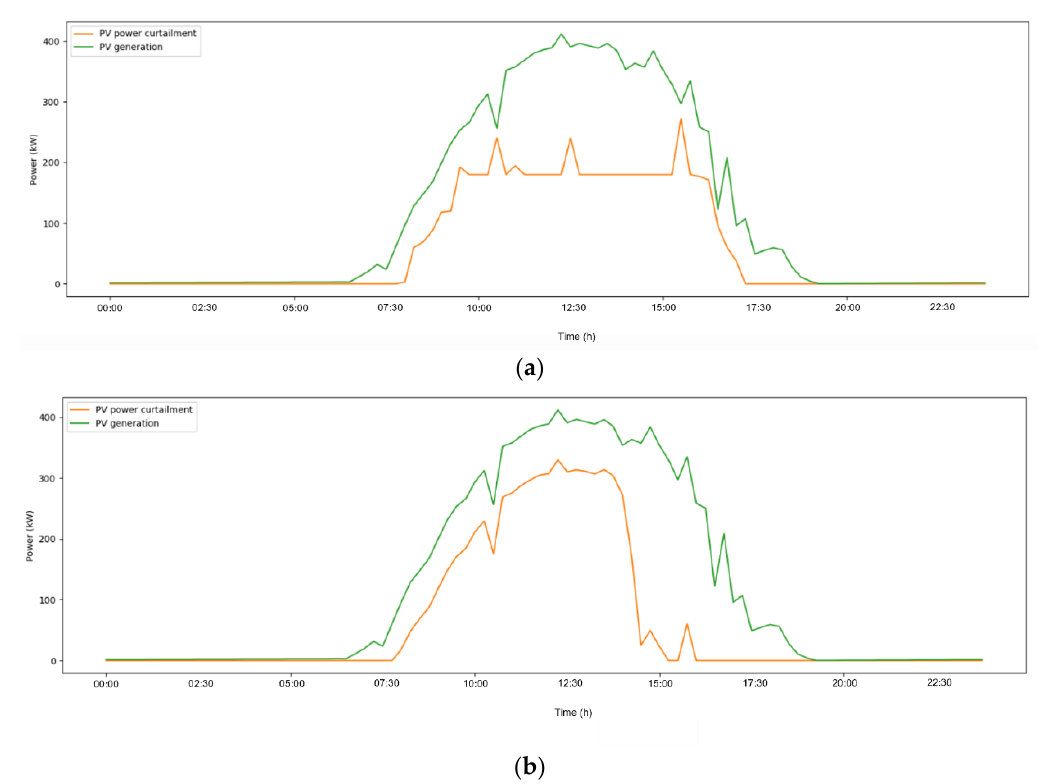
Figure 5. Microgrid optimal scheduling results comparison of curtailment gradation cost method ( a ) with linear curtailment cost method ( b ).